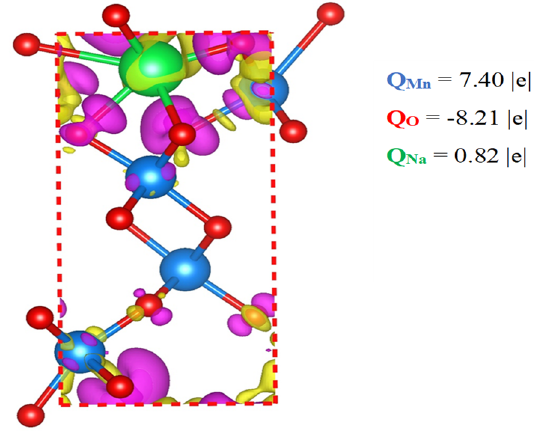
Figure 8. The charge density difference plot of Na-doped MnO 2 . The violet and yellow colors specify electron accumulation and depletion regions, respectively. The red, bluish, and green colors balls represent O, Mn, and Na atoms, respectively. The iso-surface value is set to 0.002 e Bohr −3.